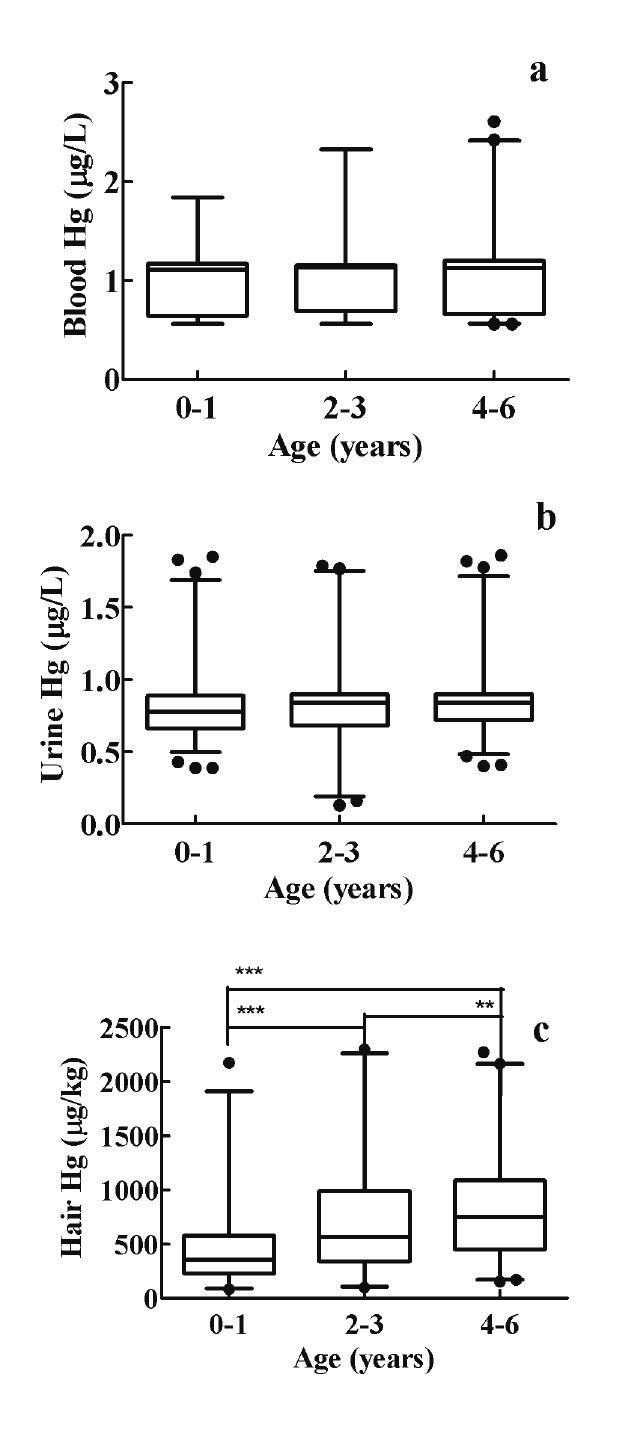
Figure 2. Box and whisker plots display the distributions of mercury levels in children in Xiamen, China ( ● outlier); ( a ), ( b ), and ( c ) show blood, urine and hair mercury levels of different age groups in